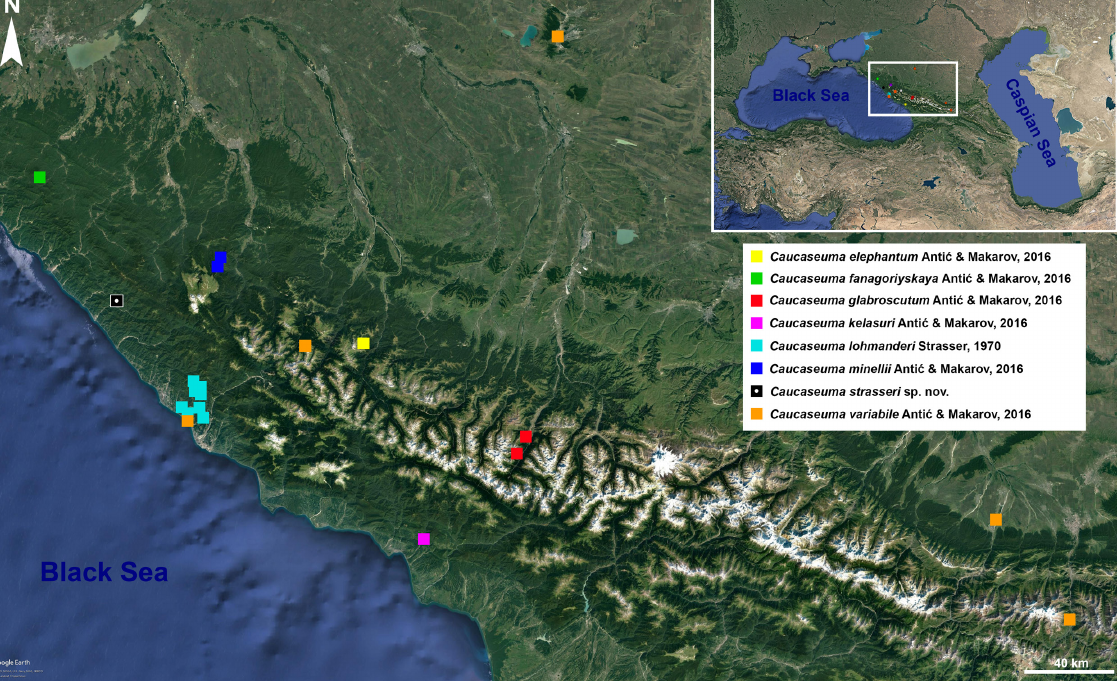
Fig. 1. Distribution of the genus Caucaseuma Strasser,